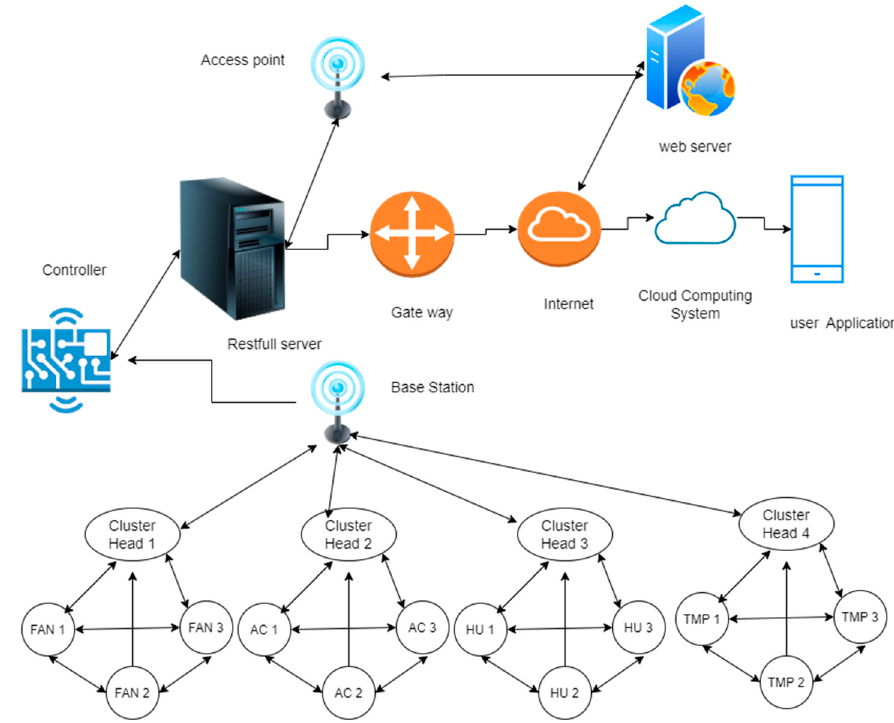
Figure 1. Typical prototype network.